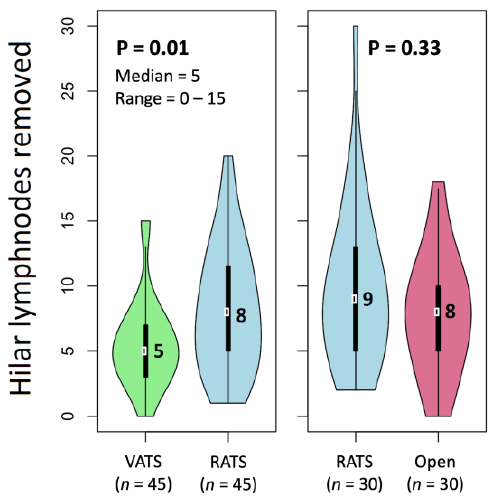
Figure 1. Differences between hilar lymph nodes resected in the different methods.